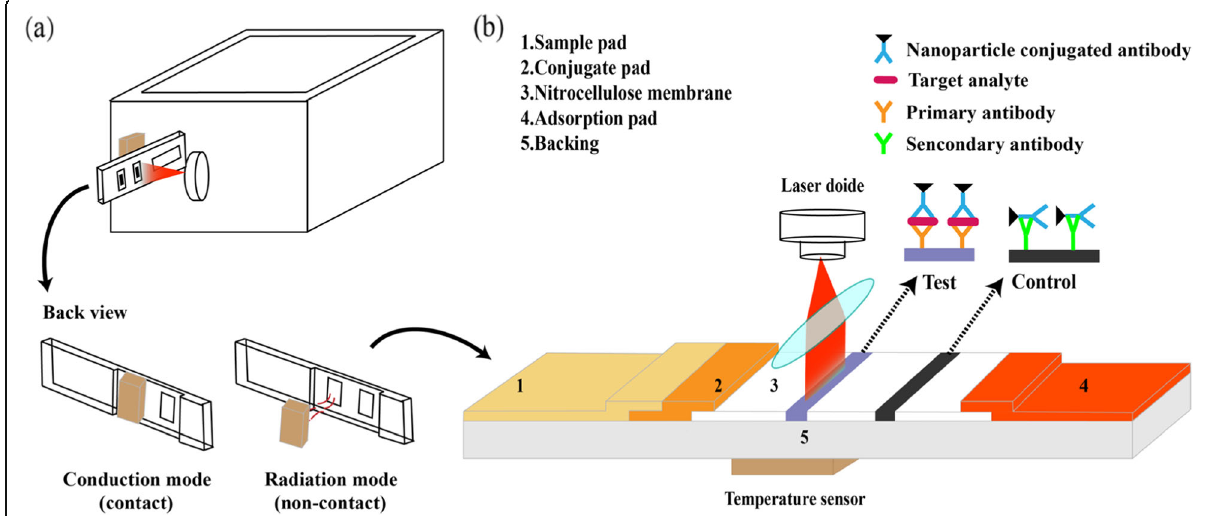
Scheme 1 Concept of plasmonic thermal sensing. a The model of portable device and the main components (top) with two different sensing modes (bottom). b LFA under thermal sensing